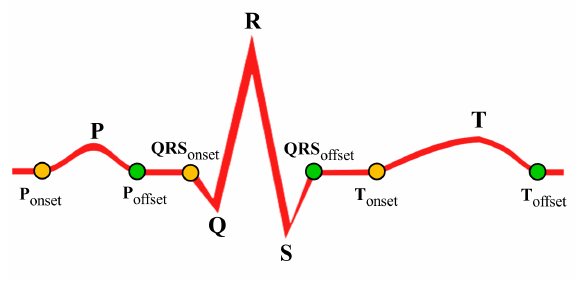
Figure 7. Example of ECG feature points, onset points and offset